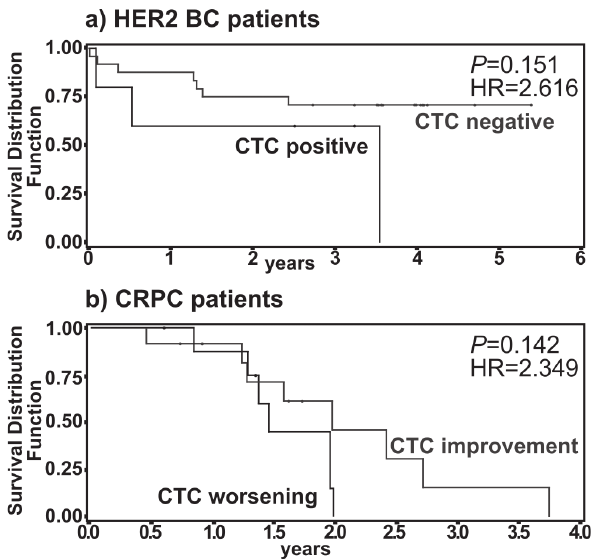
Fig. 3. Kaplan-Meier analysis of the overall survival and Hazard ration analysis (HR). a) HER2 BC patients with vs. without CTCs b) CRPC patients with CTC status worsening (Neg→Pos or Pos→Pos) vs. CTC status improvement (Pos→Neg or